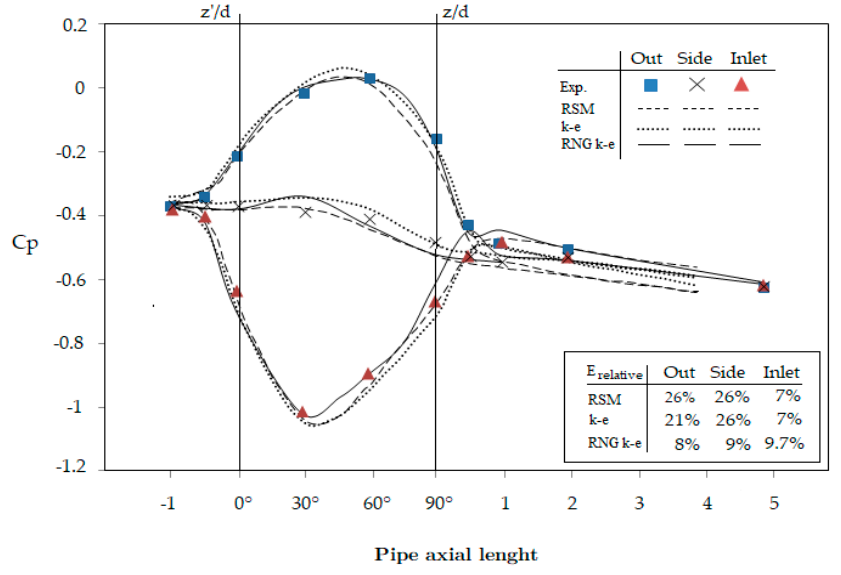
Figure 2. Comparison between experimental ( markers ) and estimated ( lines ) pressure drop values using different models. The experimental values, RSM model and k - ε are those reported by Zhang et al. [4].